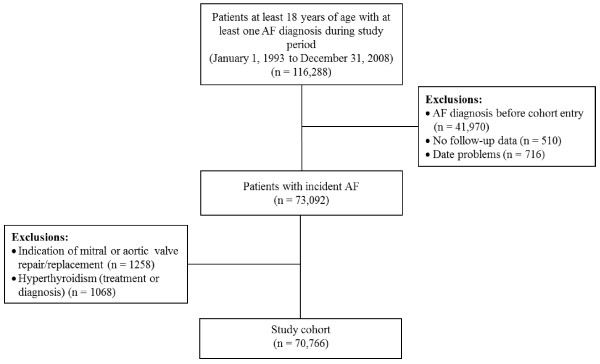
Study flow chart.